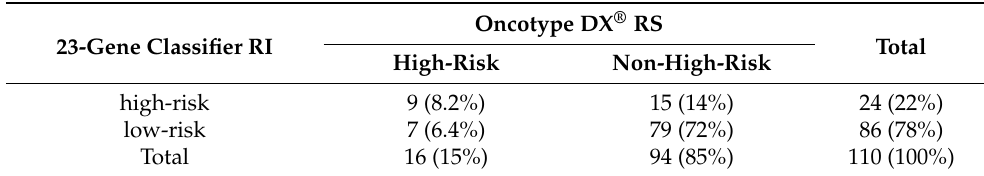
Table 6. Concordance between Oncotype DX ® RS and the 23-gene classifier RI. 23-Gene Classifier